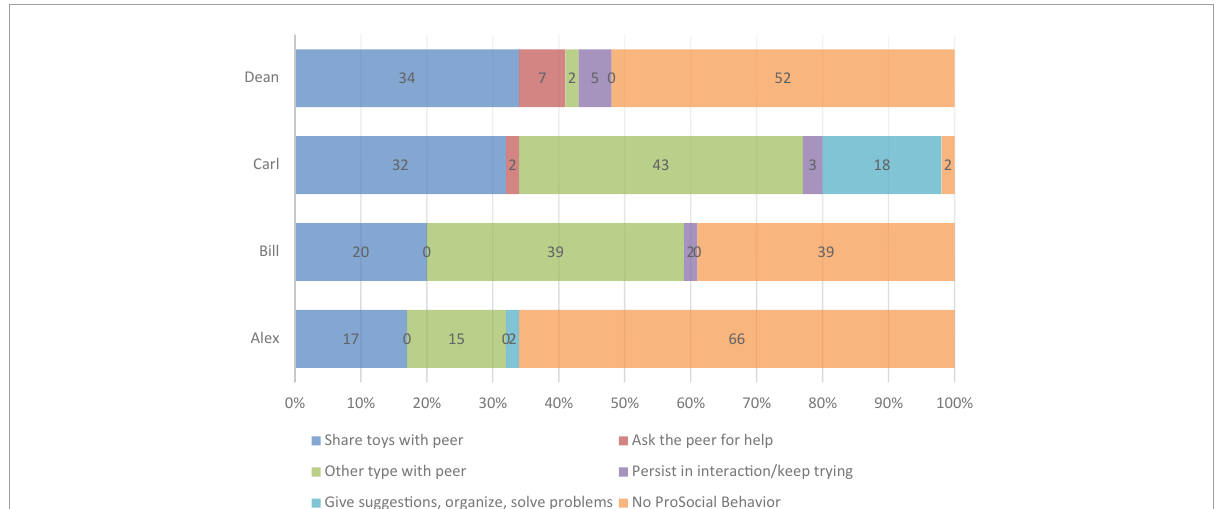
FIGURE1 Distribution of prosocial behaviors (%) for children with SEN during 12 video-recorded PT/ST playgroups with peers (15 min/child), observed with OSPIP. For Alex playgroup 5, 7, 9; for Bill playgroup 4, 10, 11; for Carl playgroup 5, 7, 11; and for Dean playgroup 3, 4, 9; PT/ST = play/time social/time (Odom et al., 1997); SEN = Special Educational Needs; OSPiP = Observation of Social Participation in Play (Allodi Westling et al., 2019).